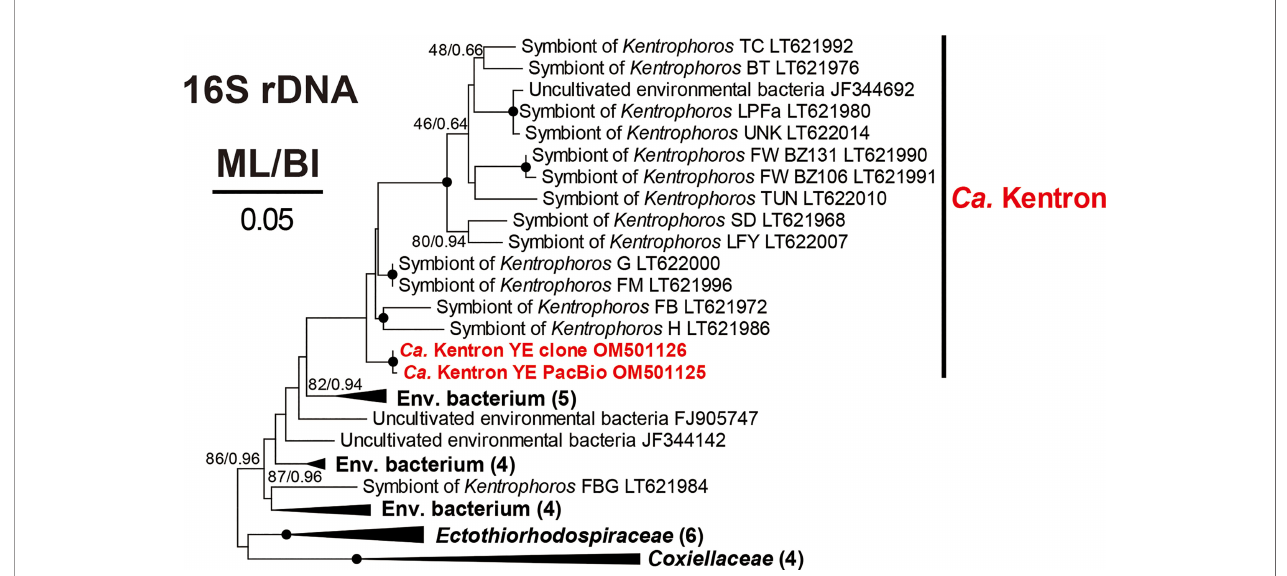
FIGURE 5 | Maximum likelihood (ML) tree based on the 16S rRNA genes showing the positions of “ Candidatus Kentron ” YE (in red) with a GTR + I + Г model. The numbers on the nodes represent the bootstrap values of ML and the posterior probability of the Bayesian inference (BI). The black dot on the node represents the bootstrap value > 95%. Genbank accession numbers are given following the species names. All branches are drawn to